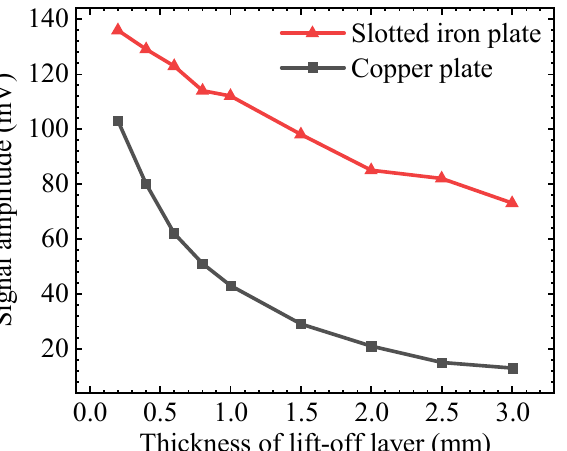
Figure 17. Relationship between the signal amplitude value of two kinds of lift-off layers and their thickness.